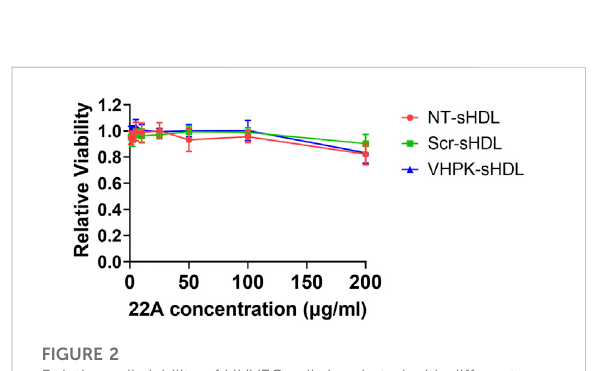
FIGURE 2 Relative cell viability of HUVEC cells incubated with different sHDLs at indicated concentrations. Cells without treatment were used as 100% ( n = 6, mean ±